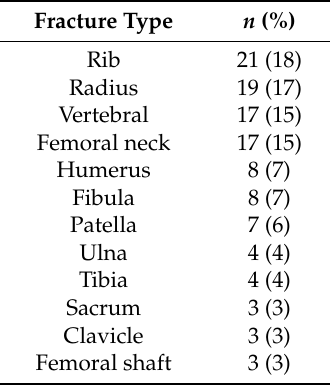
Table 2. Fracture frequency ( n =